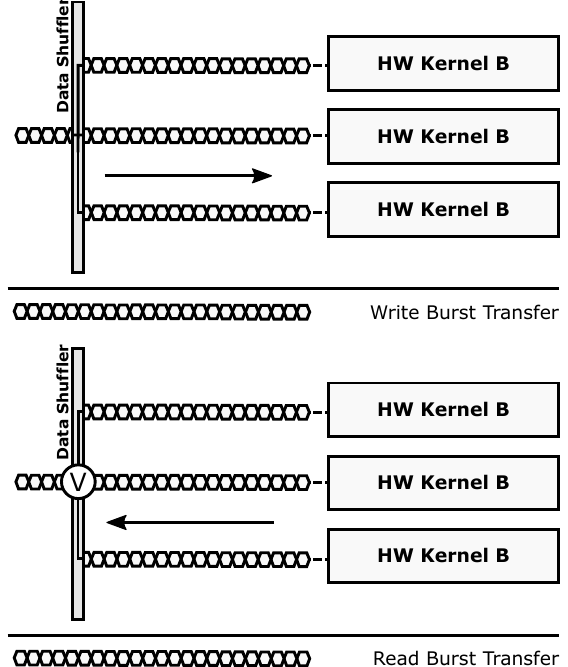
Figure 5. Redundant operation